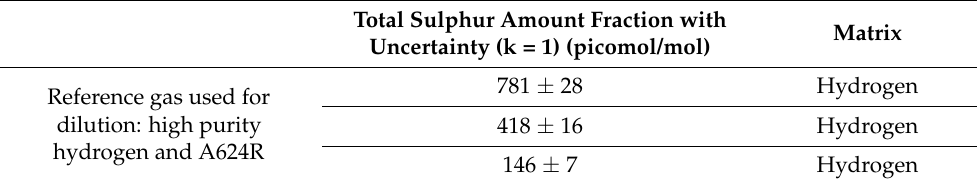
Table 2. Example of reference amount fractions of dynamic standard used in calibration curve of the total sulphur measurement by cryo-focussing GC-SCD.